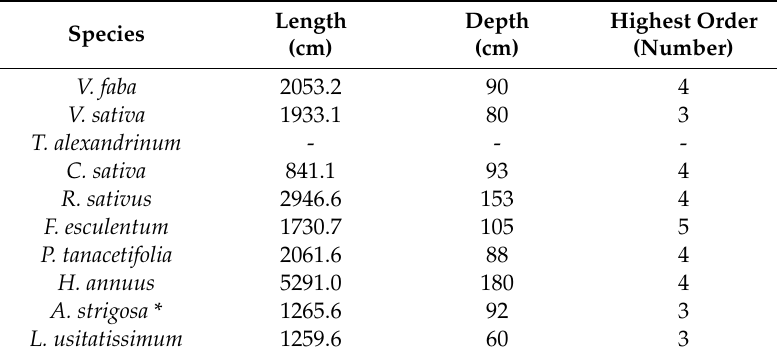
Table 3. Quantitative root characteristics from Root Atlas